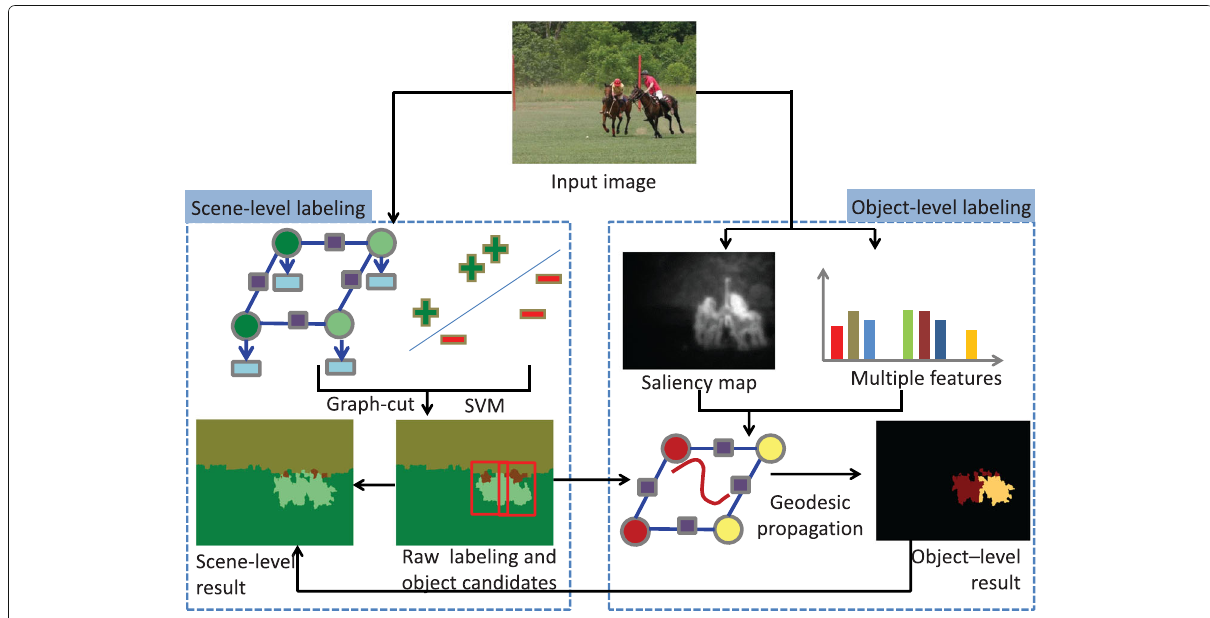
Fig. 2 Overview of our framework. See the text for more details